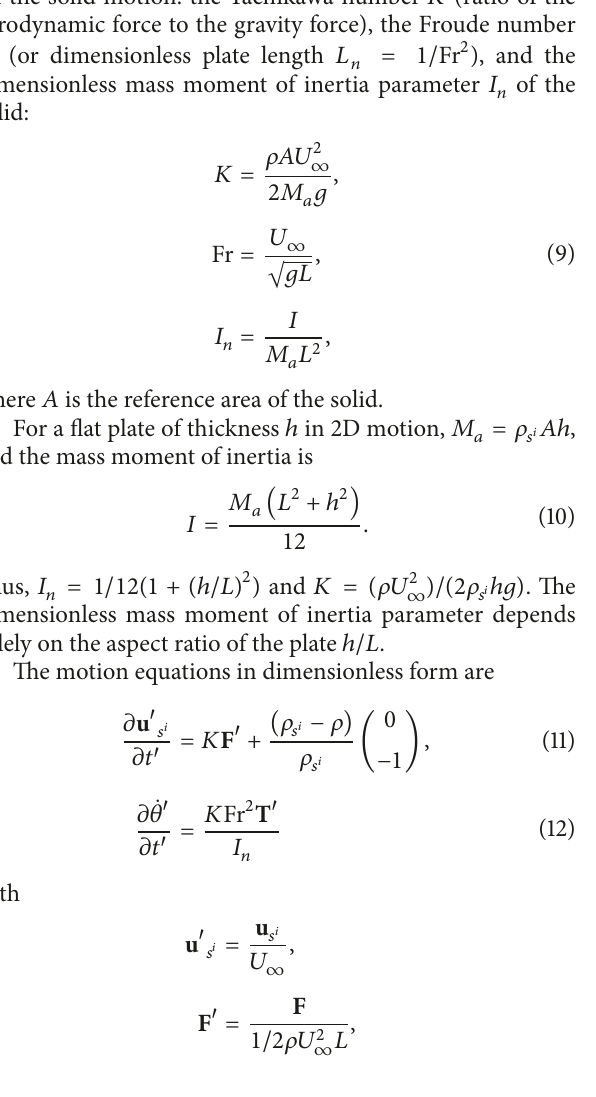
Figure 2: The penalization technique: the flow field is extended inside the body, the instantaneous vorticity, and the streamlines around a